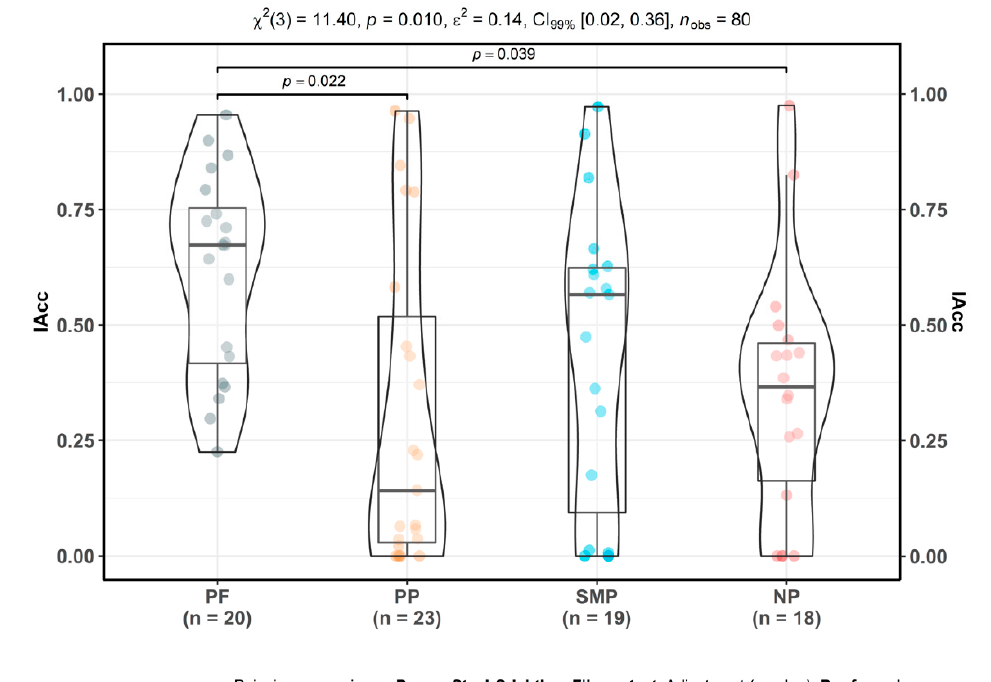
Figure 1. Interoceptive accuracy (IAcc) alterations in CP. PF: pain-free participants. PP: primary CP participants, SMP: secondary musculoskeletal CP participants, NP: neuropathic CP participants. Mean values: PF µ = 0.61, CI 95% (0.51, 0.71), PP µ = 0.31, CI 95% (0.16, 0.46), SMP µ = 0.44, CI 95% (0.29, 0.59), NP µ = 0.35, CI 95% (0.22, 0.48).